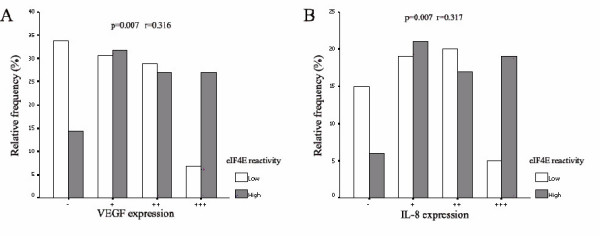
Graphical representation for analysis of the correlation between eIF4E expression and VEGF levels (A) as well as with IL8 expression (B) in breast cancer.